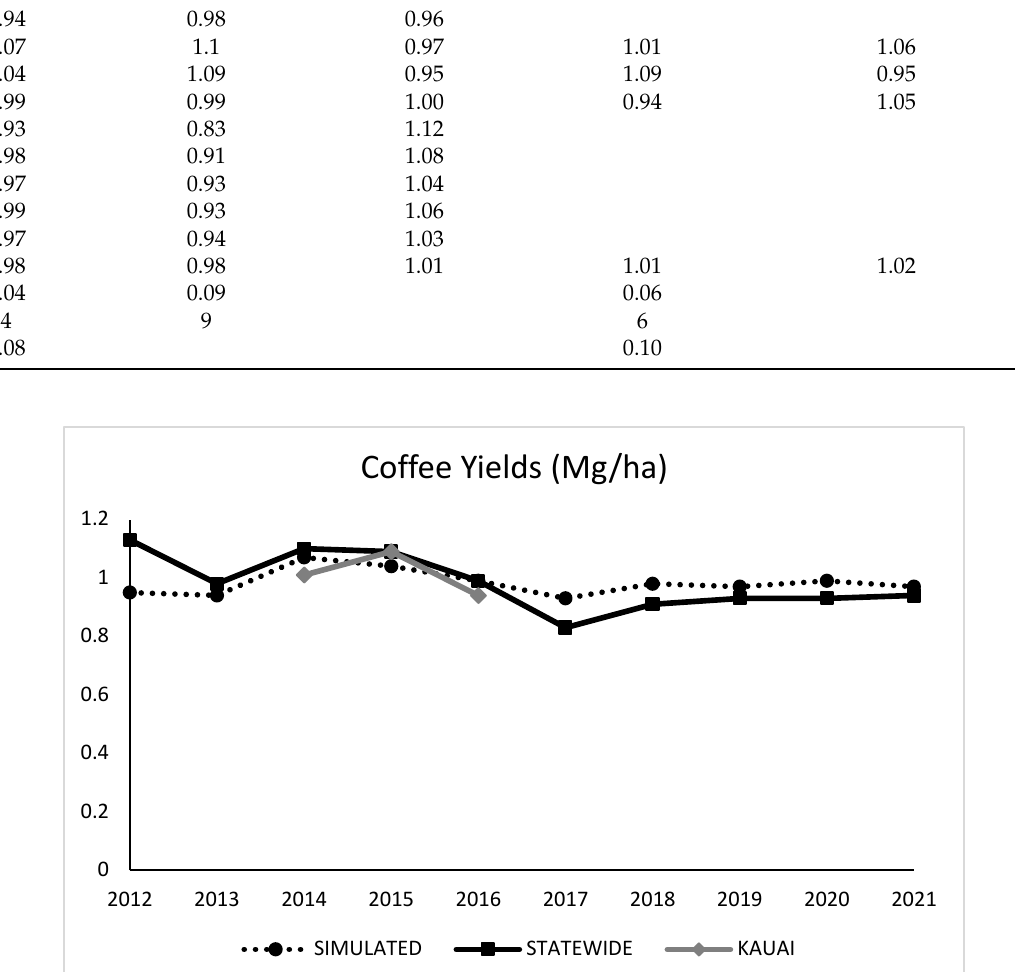
Figure 1. Coffee yields (in Hawai’i) measured and simulated with the ALMANAC model.